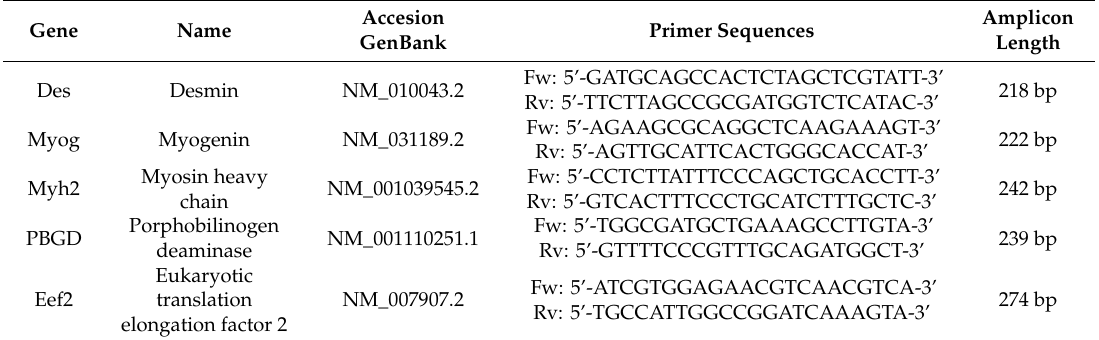
Table 1. Genes and primer sequences used in real-time quantitative polymerase chain reaction